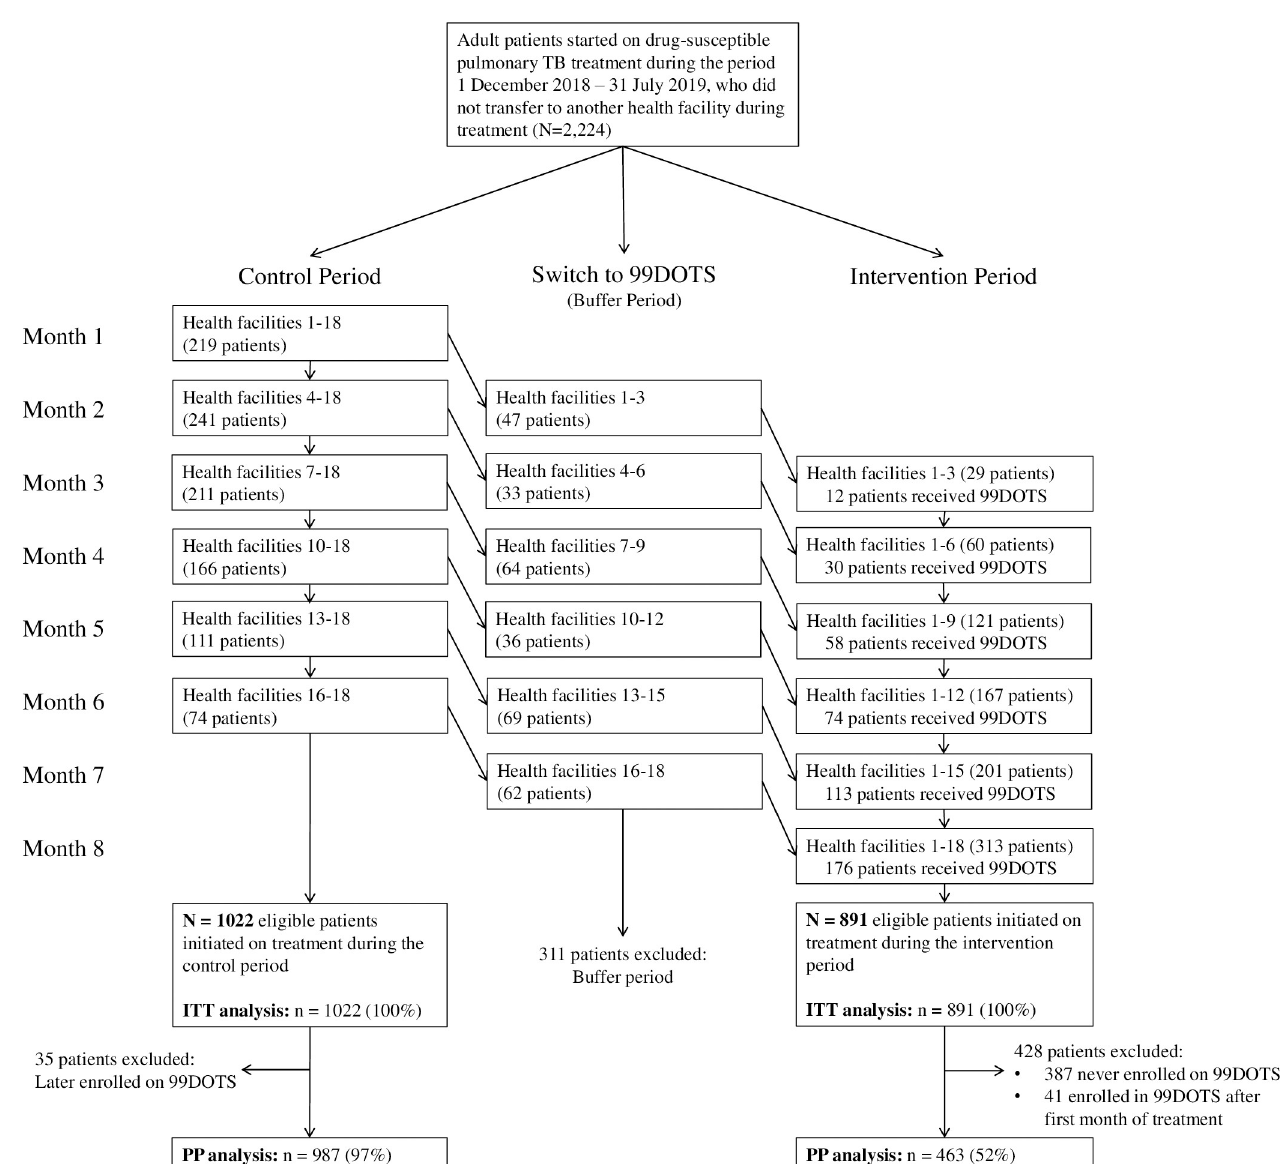
Fig 1. Trial profile. ITT, intention-to-treat; PP, per protocol; TB, tuberculosis.